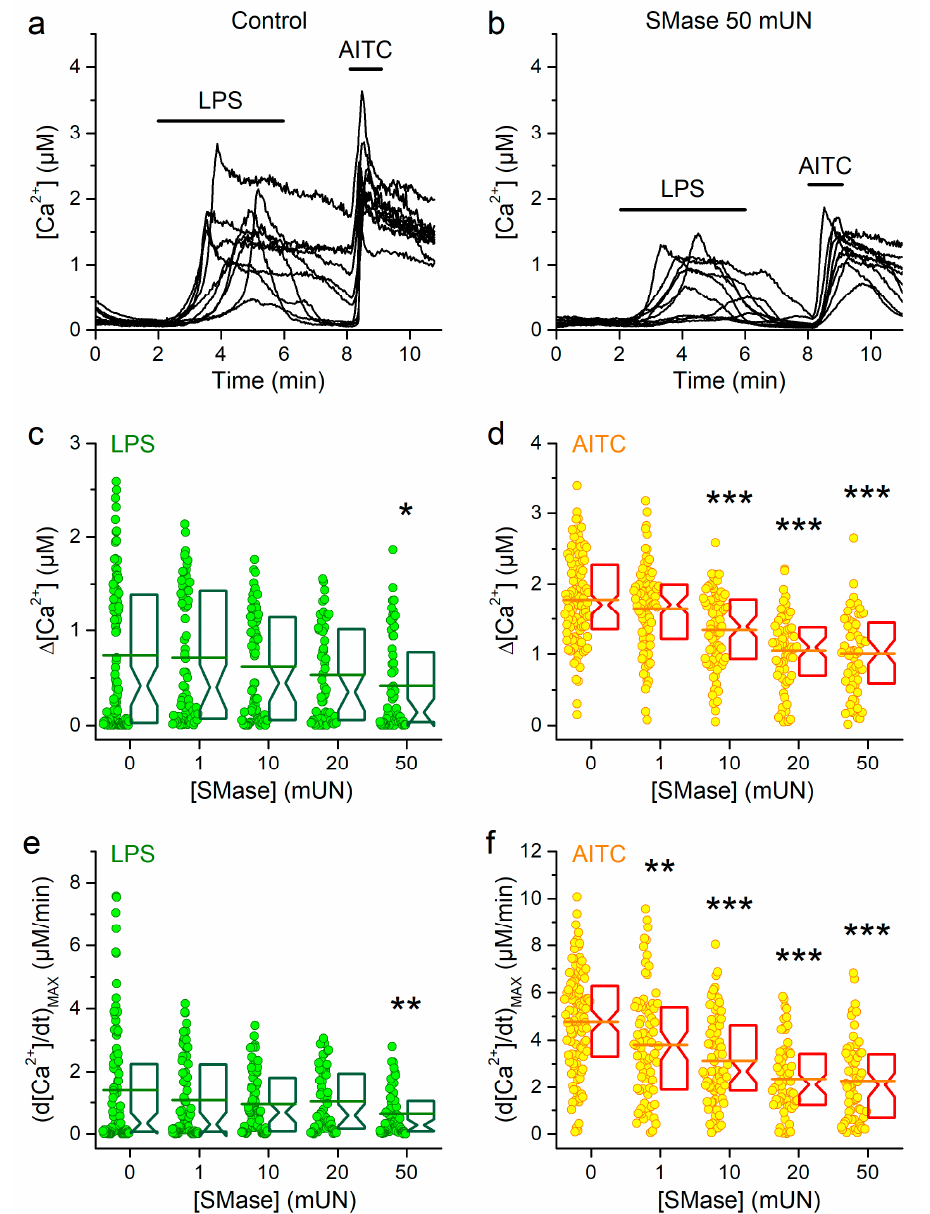
Figure 4. Effects of SMase pretreatment on mTRPA1 responses to LPS. ( a and b ) Representative [Ca 2+ ] traces showing the effects of E. coli LPS (20 µg/mL) in control condition ( a ) and after pretreatment with 50 mUN SMase ( b ). Application of AITC (100 µM) was used as control for mTRPA1 activation. ( c and d ) Average amplitude of [Ca 2+ ] responses to LPS ( c ) and AITC ( d ) in control condition ( n = 108) or after pretreatment with 1 ( n = 83), 10 ( n = 75), 20 ( n = 60) or 50 mUN ( n = 64) of SMase. Maximal amplitude of the first time derivative of the intracellular Ca 2+ signal elicited by LPS ( e ) and AITC ( f ) in control condition or after treatment with 1, 10, 20 or 50 mUN of SMase (the n numbers are the same as in panels c and d). The symbols *, ** and *** indicate p < 0.05, p < 0.01 and p < 0.001, respectively; Kolmogorov–Smirnov test.